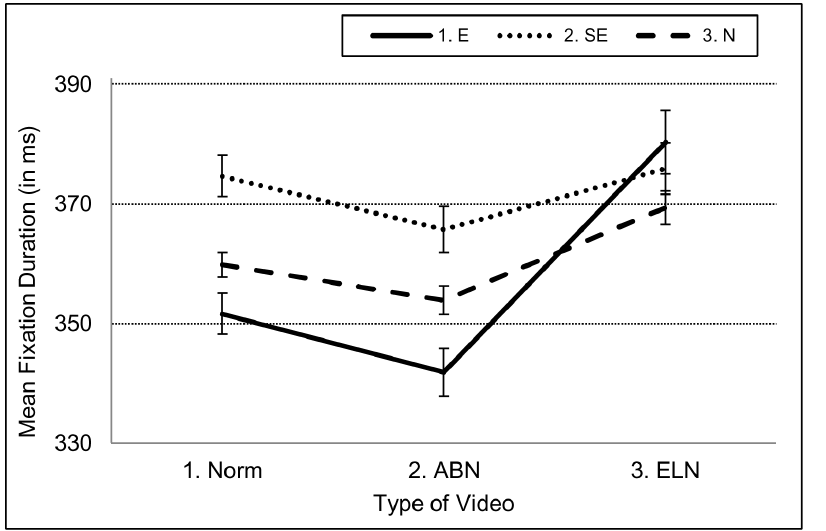
Figure 5. Interaction between Expertise and Video for average fixation duration. The figure depicts that experts reverted to longer fixation durations in ELN-videos than in other videos, whereas semi-experts and naı¨ve participants did not.